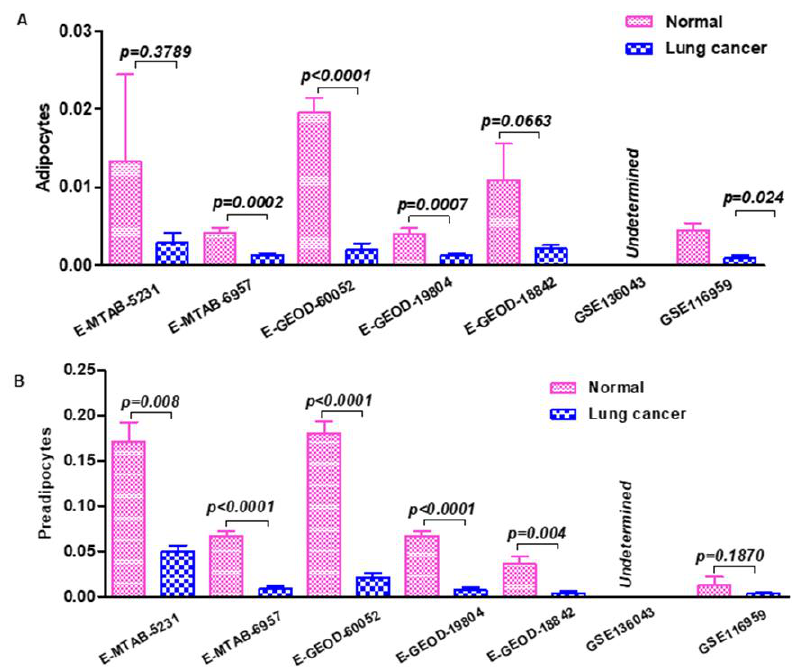
Figure 1. Tumor heterogeneity analysis to estimate adipocyte and preadipocyte population in lung cancer compared to normal lung tissue. ( A ) Fraction of adipocytes in normal healthy lungs vs. lung cancer in multiple data sets calculated using xCell. ( B ) Fraction of preadipocytes in normal healthy lungs vs. lung cancer in multiple data sets calculated using xCell.